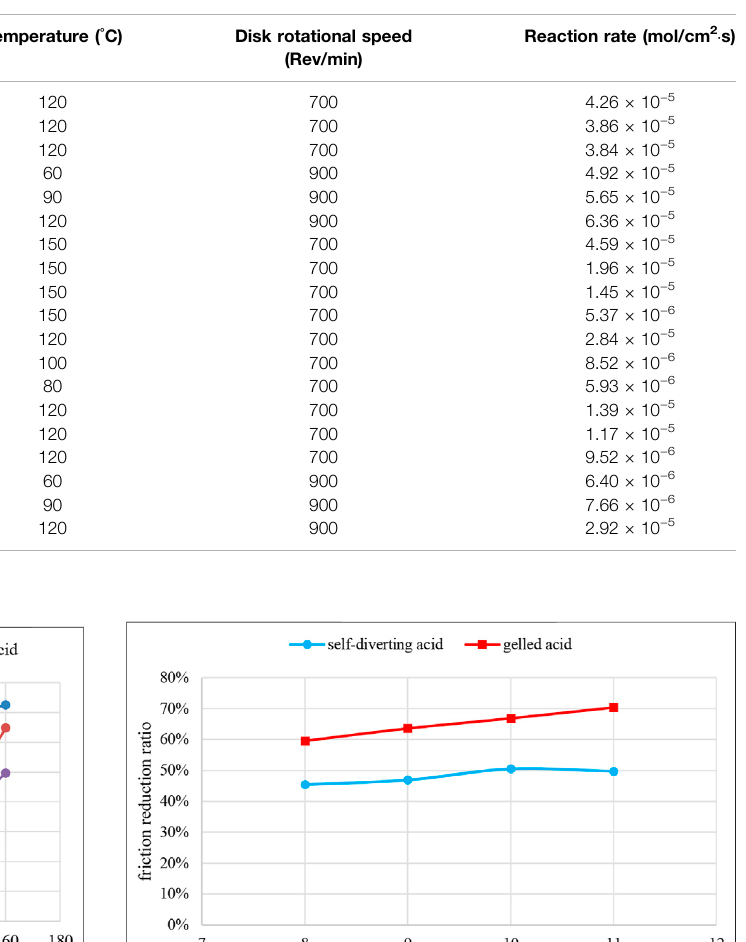
TABLE 1 | Summary of the acid rock reaction rate.